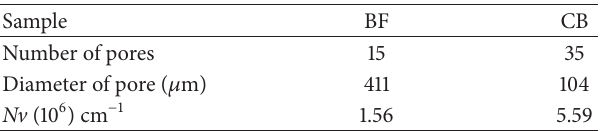
Table 3: Number, diameter, and pore density per volume of BF and CB